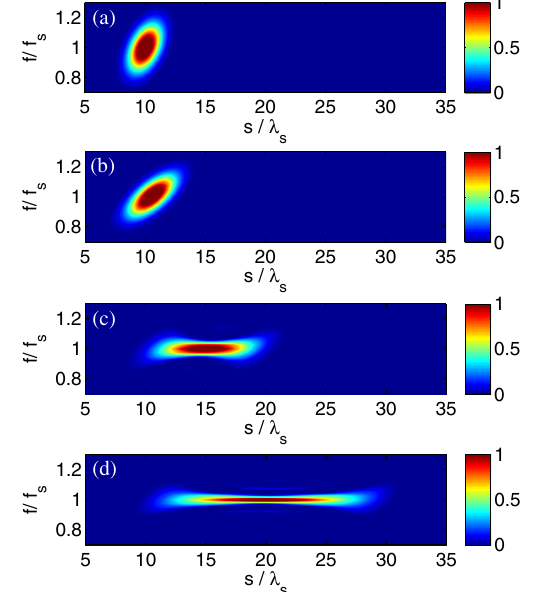
FIG. 3. Wigner distributions of the seed laser with FWHM pulse length of 3 (cid:1) s (a) and energy modulations (b)–(d) for different period numbers of the modulator ( N ¼ 1 ; 10 ; 20 ). The frequency chirp in the seed laser pulse is (cid:6) ¼ 0 : 16 =(cid:1) s 2